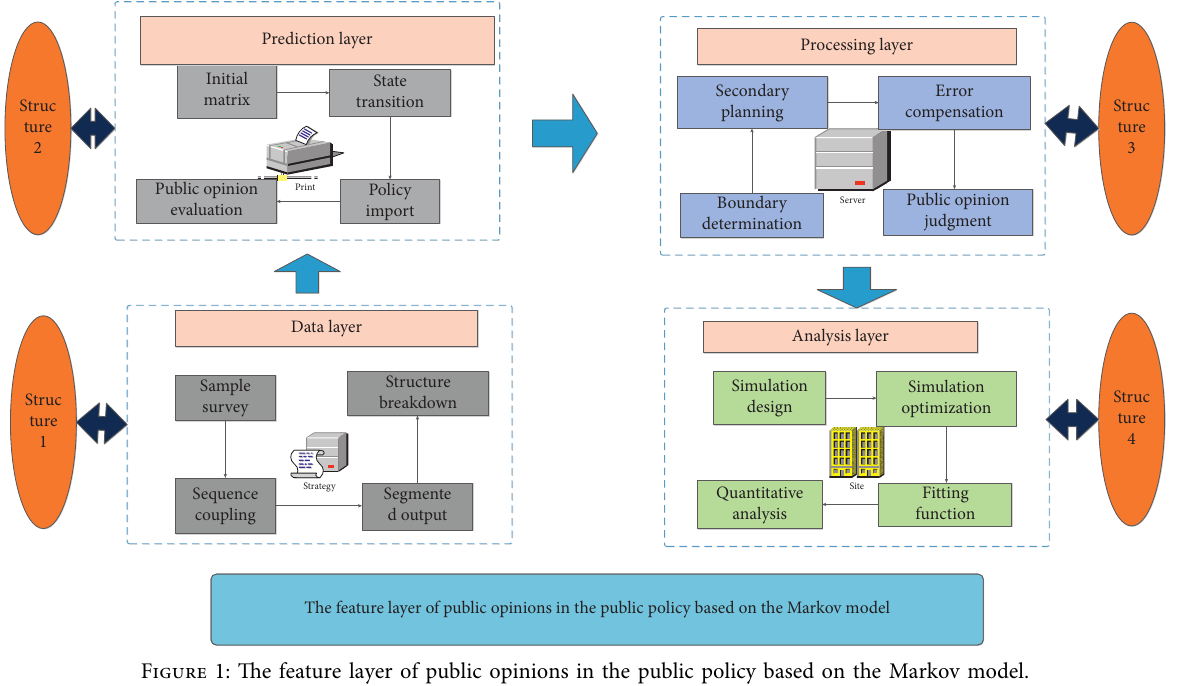
Figure 1: The feature layer of public opinions in the public policy based on the Markov model.